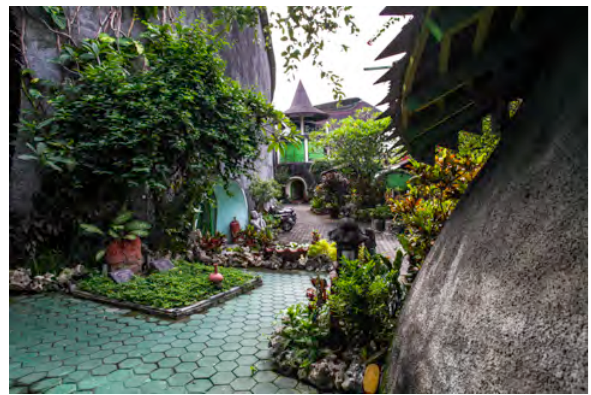
Figure 2: Affandi’s grave at the Museum Affandi (U. Herbig